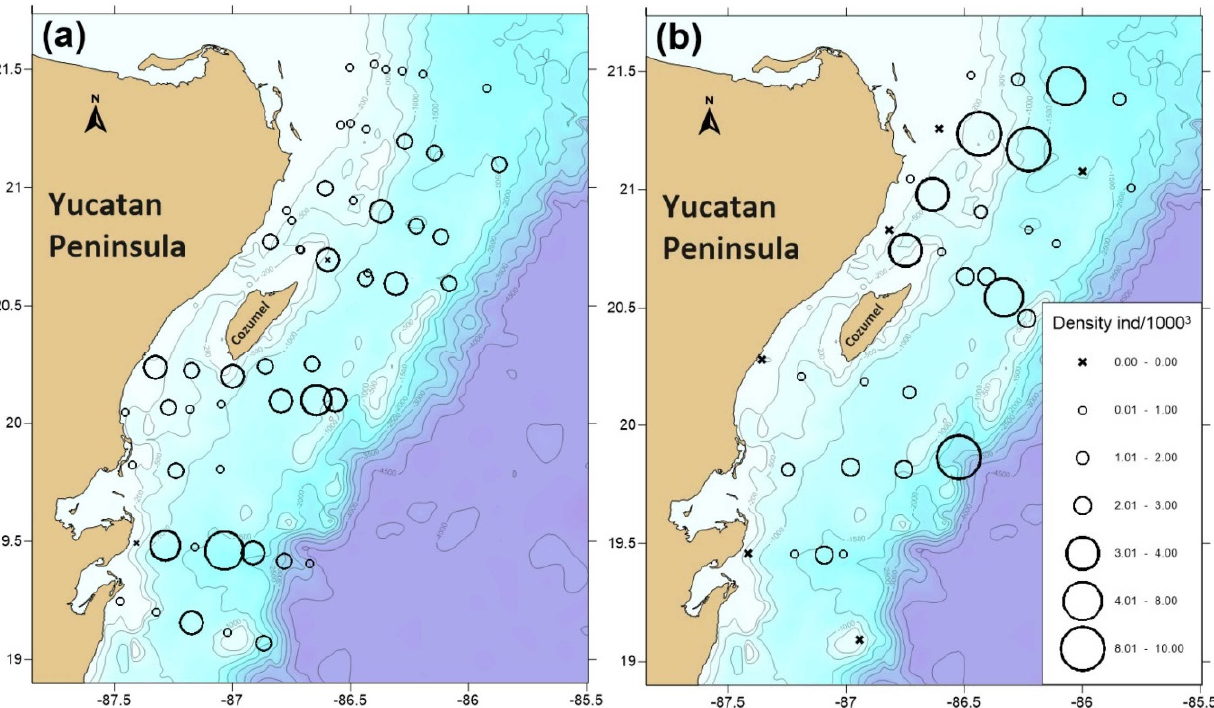
Figure 4. Density (number of larvae per 1000 m 3 of water) of phyllosomata (all species and stages combined) by sampling station. ( a ) autumn cruise; ( b ) spring cruise. The scale is the same for both panels.